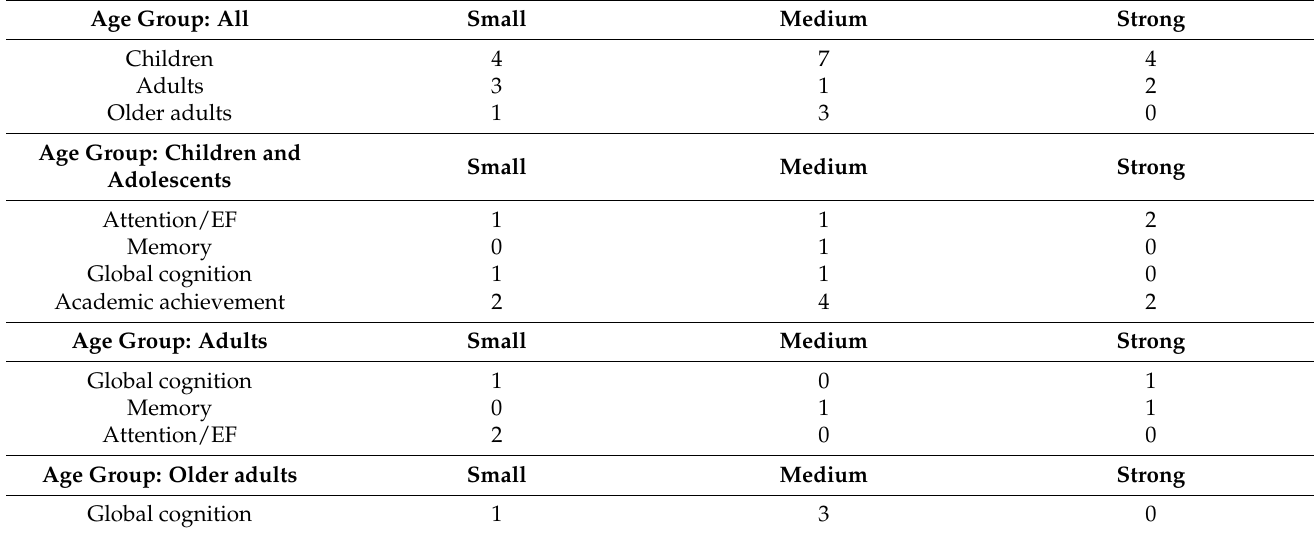
Table 3. Frequencies of small association, medium association, and strong association for the age groups, and within each age group for each cognitive